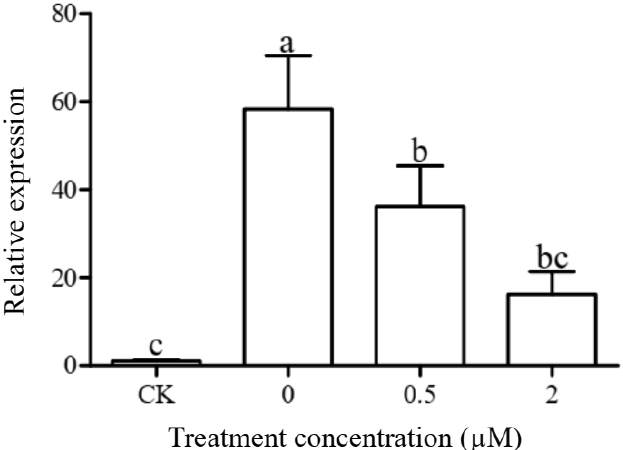
Figure 3. Effects of auxin on SbSGT1 expression at the transcriptional level in Nicotiana benthamiana . NbEF1 : Internal reference gene; Different lowercase letters indicate the significance of the difference in variance between the treatment groups ( p < 0.05).